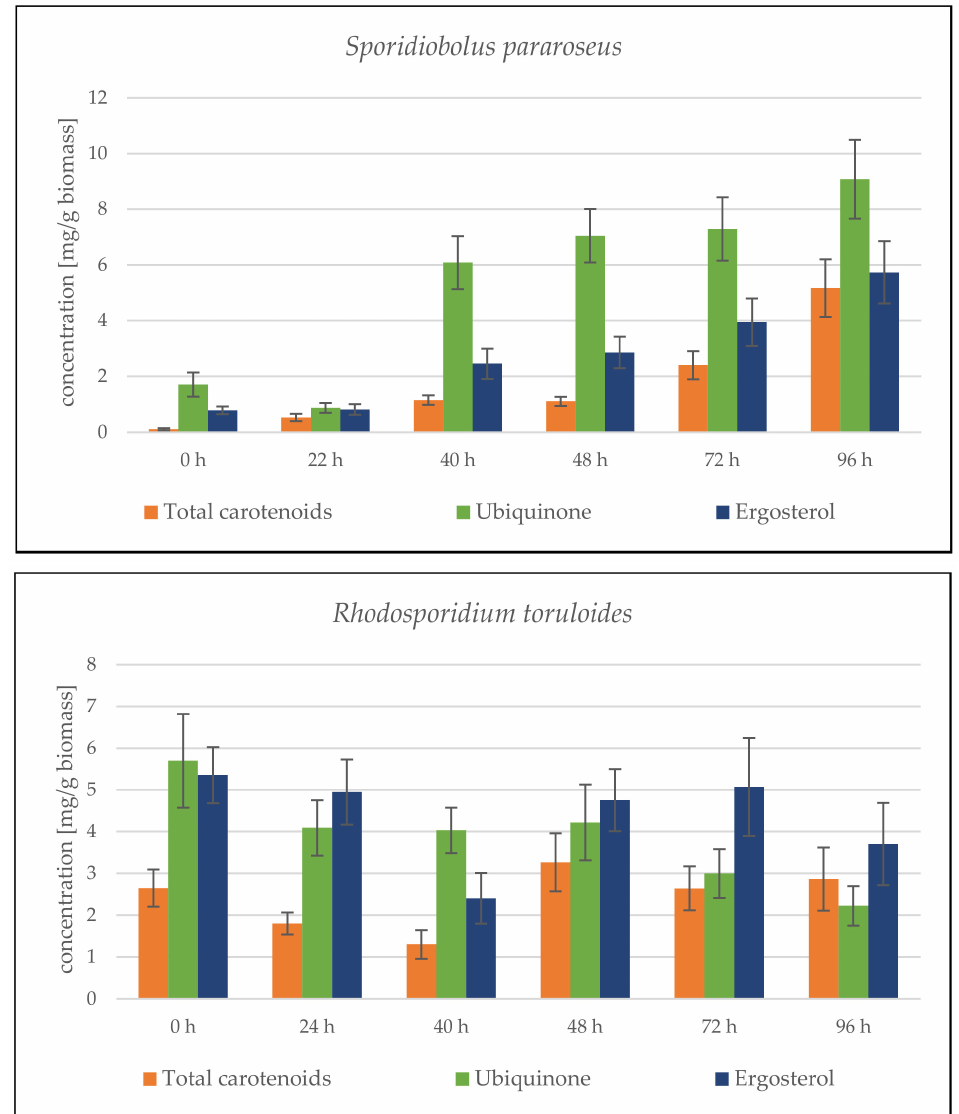
Figure 7. HPLC analysis of Sporidiobolus pararoseus and Rhodosporidium toruloides : 96 h bioreactor cultivation on SCG hydrolysate + waste frying